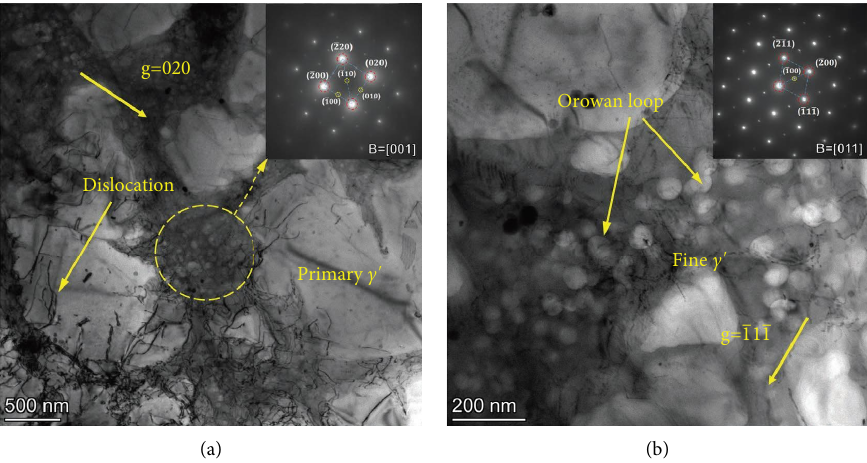
Figure 13: TEM micrographs of the K417G alloy after the stress rupture test at 760 ° C and 645MPa. Primary c ′ phase particles sheared by dislocations (a) and (b) fne c ′ phase particles surrounded by the Orowan